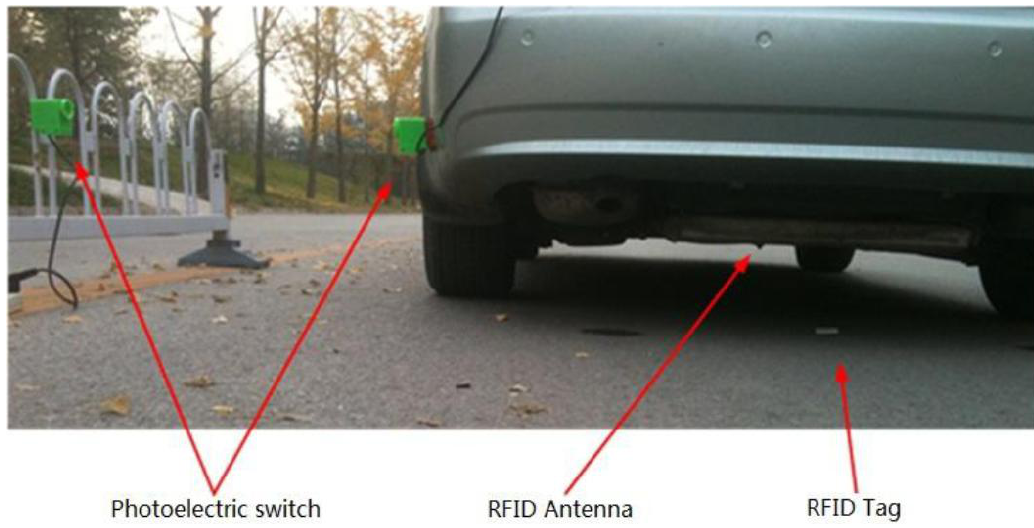
Figure 7. Setup of experimental verification based on photoelectric